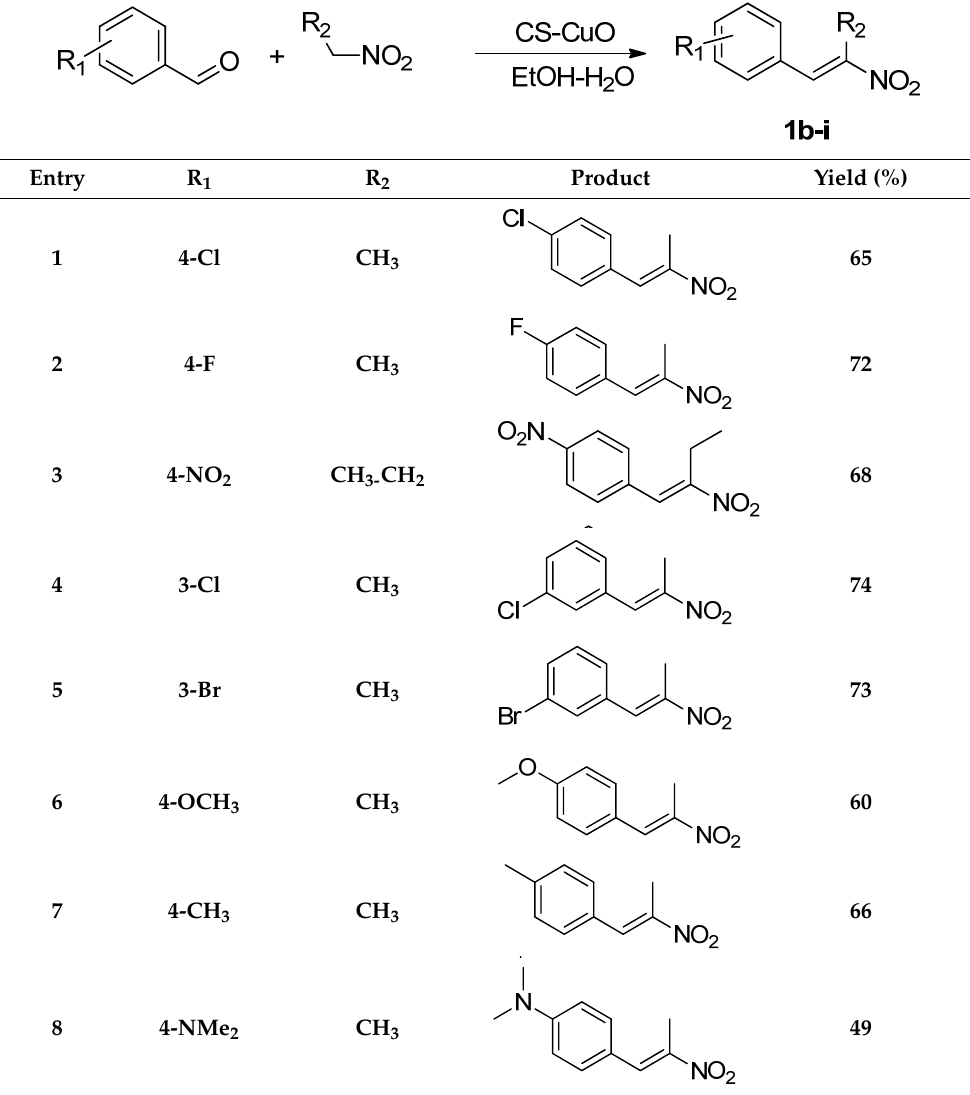
Table 2. Scope of the reaction.